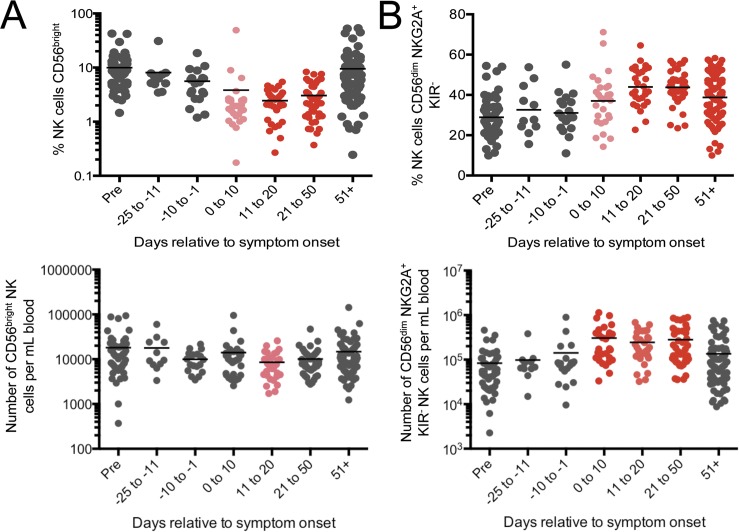
NKG2A+ NK cells were expanded during AIM, but not during the incubation period.(A) Percentage and number of NK cells that are CD56bright (immature) decreases during the first 50 days after symptom onset. (B) The percentage and number of NK cells that are CD56dim NKG2A+ KIR- increases, and remains elevated. Statistics were performed using a one-way ANOVA with multiple test comparison. Pink symbols indicate a significant difference (p<0.05) compared to pre-infection. Red symbols indicate a significant difference (p<0.0001) compared to pre-infection. Gray symbols indicate no statistical difference.